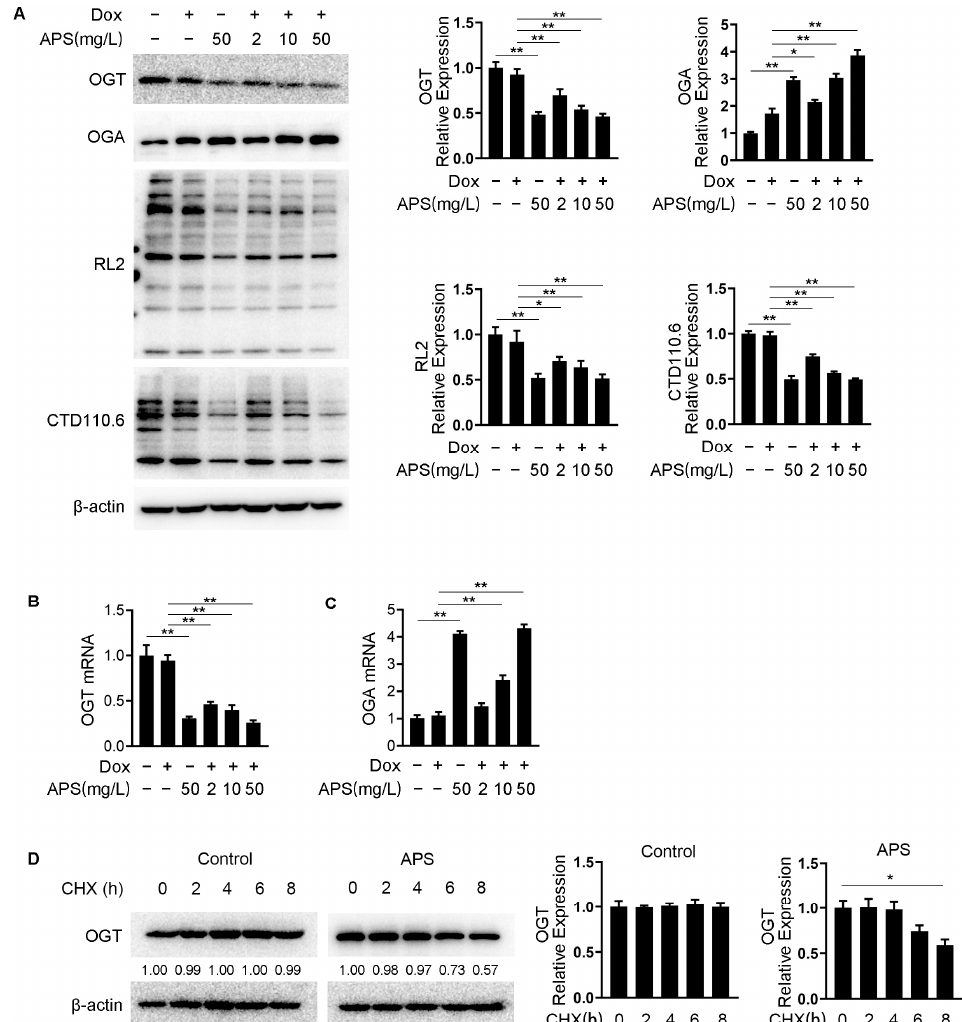
Figure 3. APS down-regulates O-GlcNAcylation through decreasing OGT level and increasing OGA level in Hep3B cells. Hep3B cells were treated with 1 µ M Dox along with or without increasing doses of APS (2, 10, 50 mg/L). ( A ) Expression levels of OGT, OGA, RL2 and CTD110.6 were examined using Western blots. β -actin was used as an internal control. The mRNA levels of OGT ( B ) and OGA ( C ) in Hep3B cells were measured using real-time PCR. ( D ) Hep3B cells treated with or without 50 mg/L APS were subjected to Cycloheximide (CHX) chase analysis for OGT stability detection. Cells were harvested at indicated time points under 50 μ M CHX treatment. Data are expressed as mean ± SEM from three independent experiments. *, p < 0.05, **, p < 0.01.